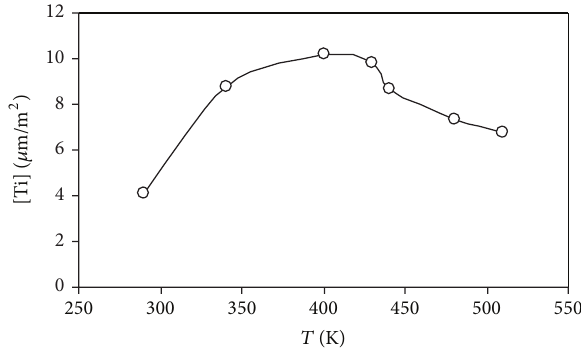
Figure 5: The dependence of Ti content in nanolayer from synthesis